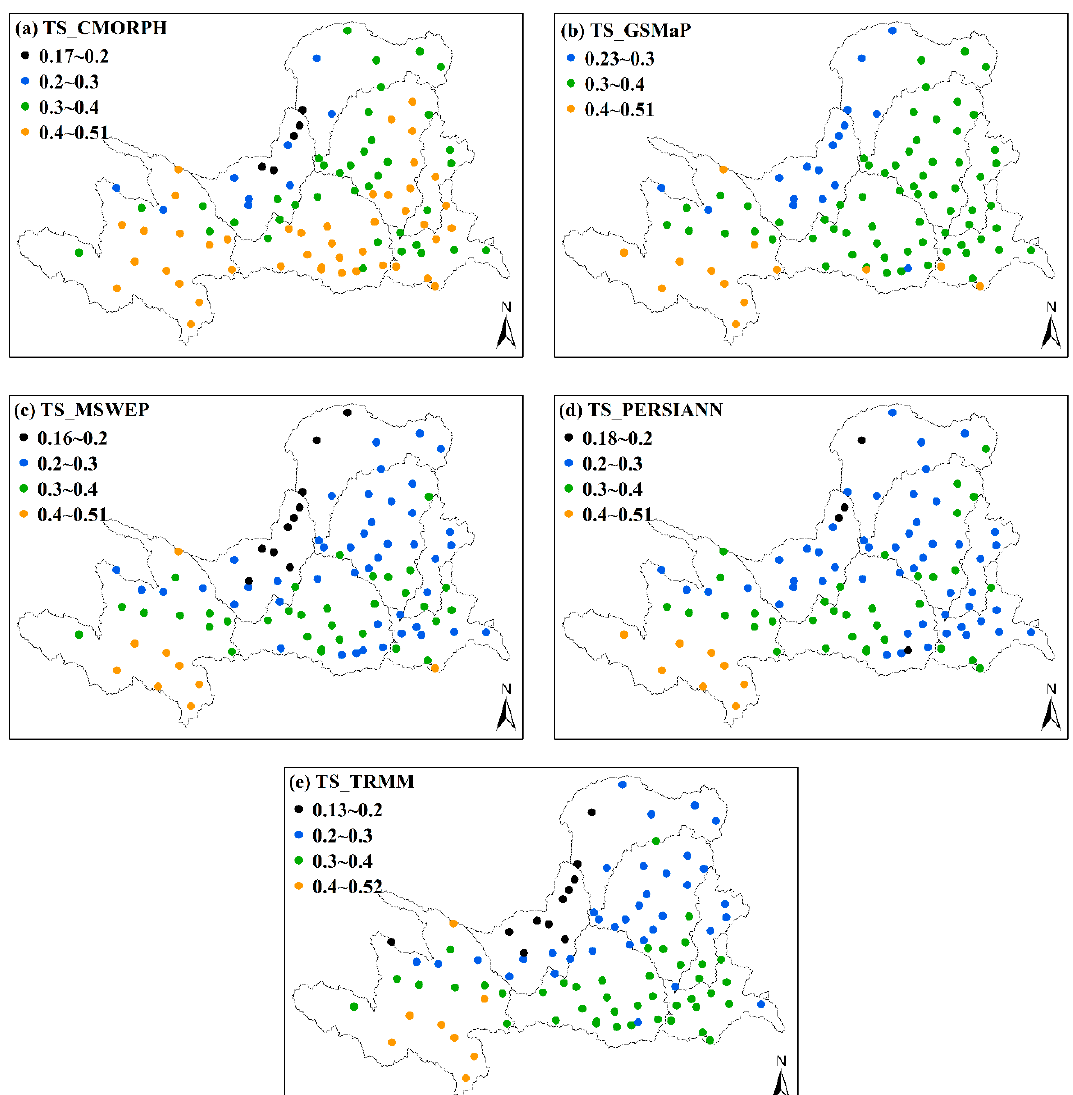
Figure 10. Spatial pattern of TS (threat score).